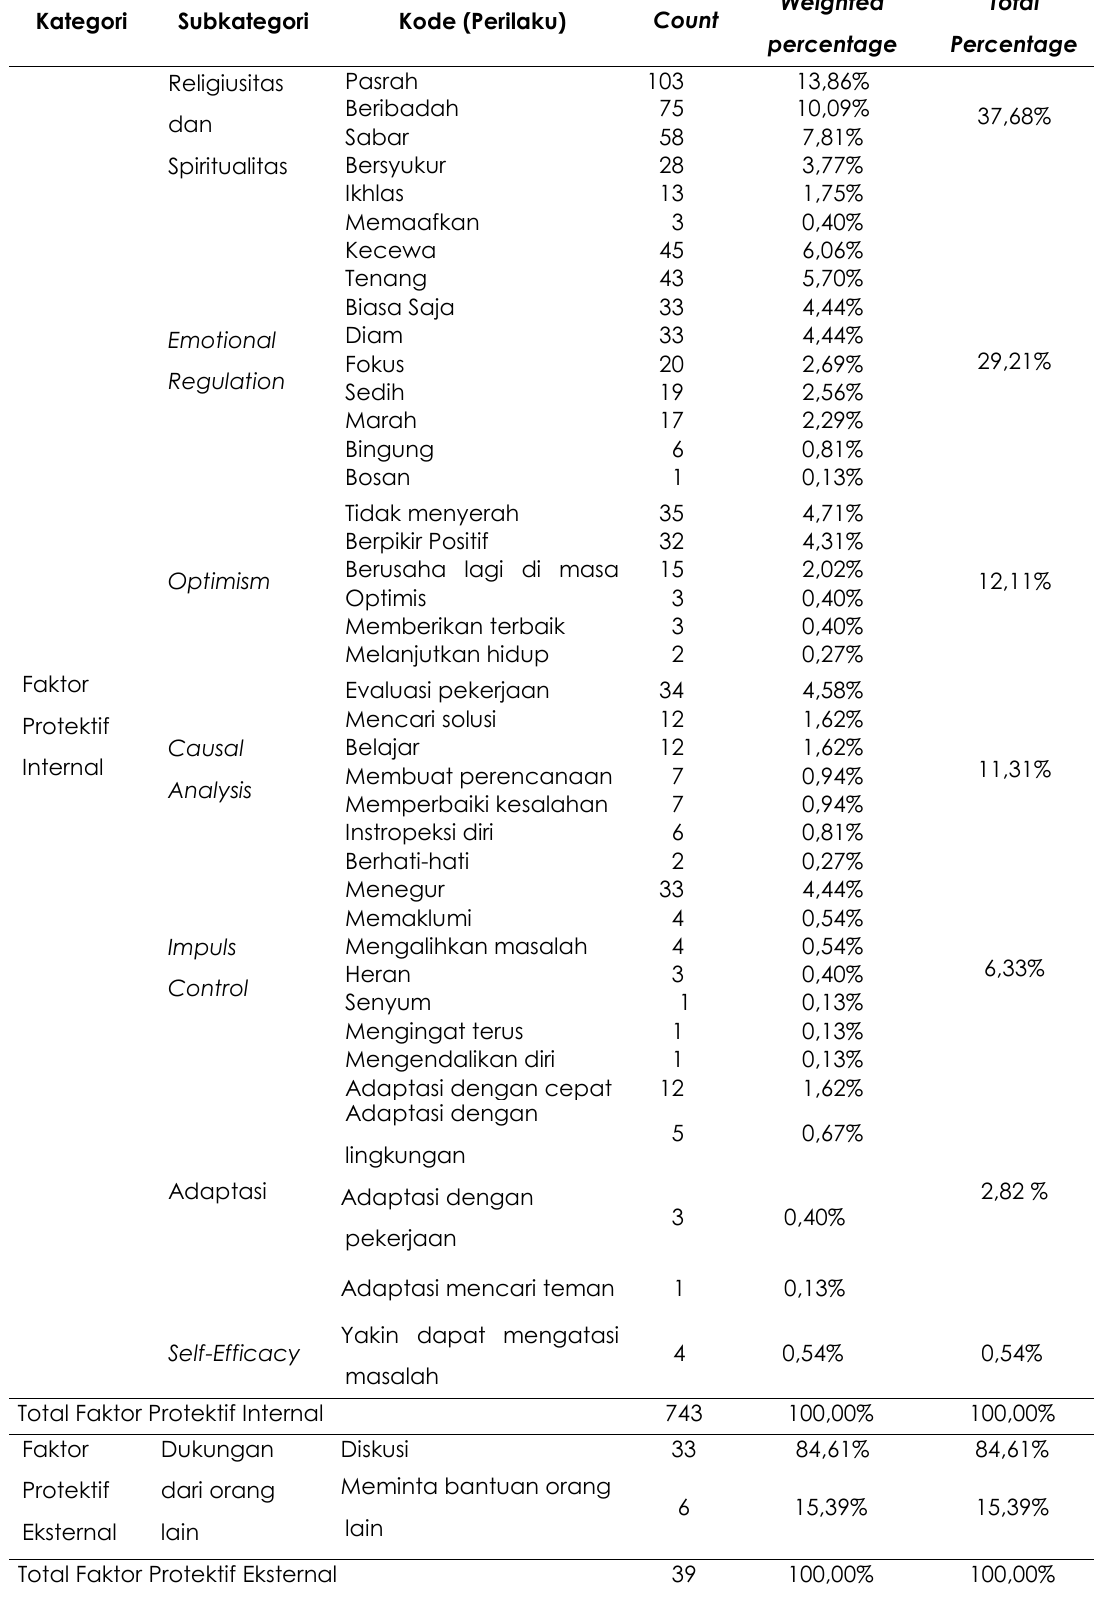
Tabel 2. Qualitative Content Analysis Tema Faktor